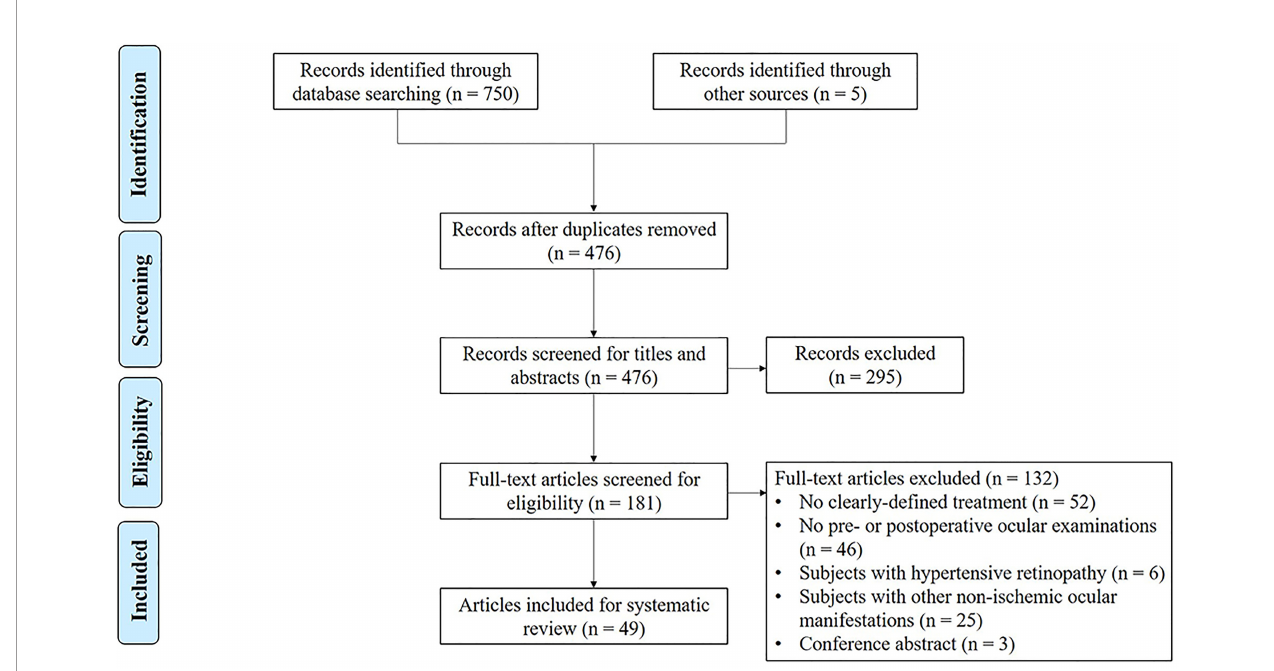
FIGURE 6 | Preferred Reporting Items for Systematic Reviews and Meta-Analyses (PRISMA) fl owchart of the study selection